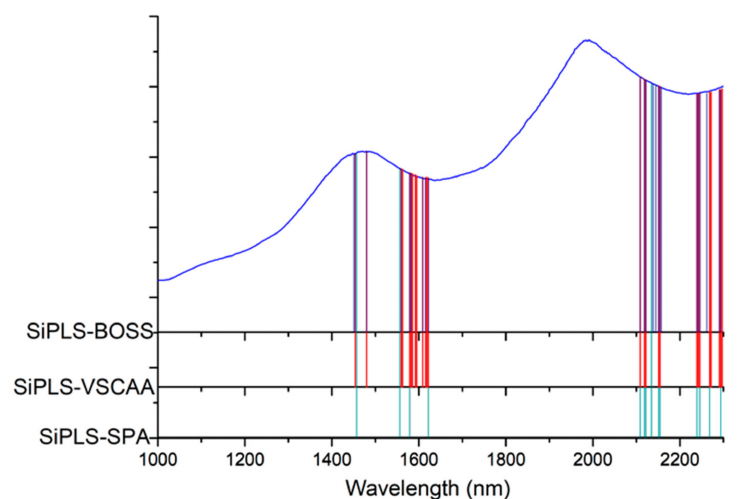
Figure 7. The useful variables selected by SiPLS-SPA, SiPLS-VSCAA, and SiPLS-BOSS. SIPLS-BOSS: synergy interval partial least squares-bootstrapping soft shrinkage; SIPLS-VSCAA: synergy interval partial least squares-variable stability and cluster analysis algorithm; SiPLS-SPA: synergy interval partial least squares-successive projections